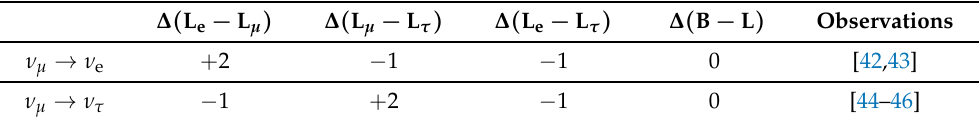
Table 1. Selection rules of the observed violations of the exact global symmetries of the stan- dard